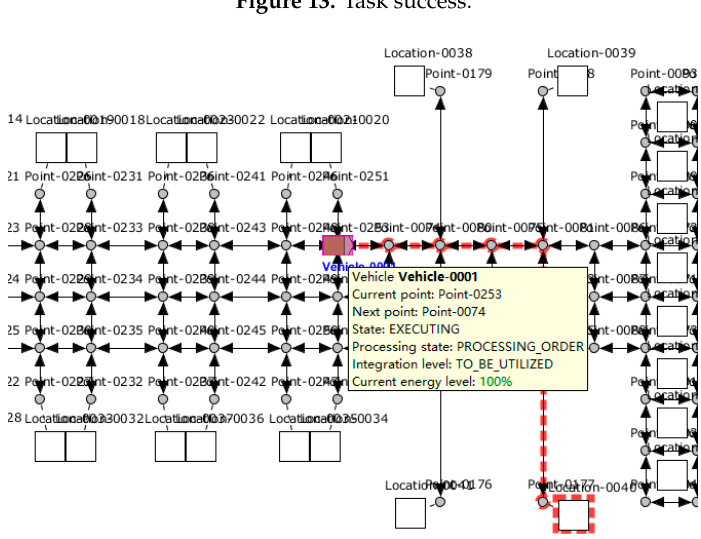
Figure 13. AGV status during operation. Figure 14. AGV status during